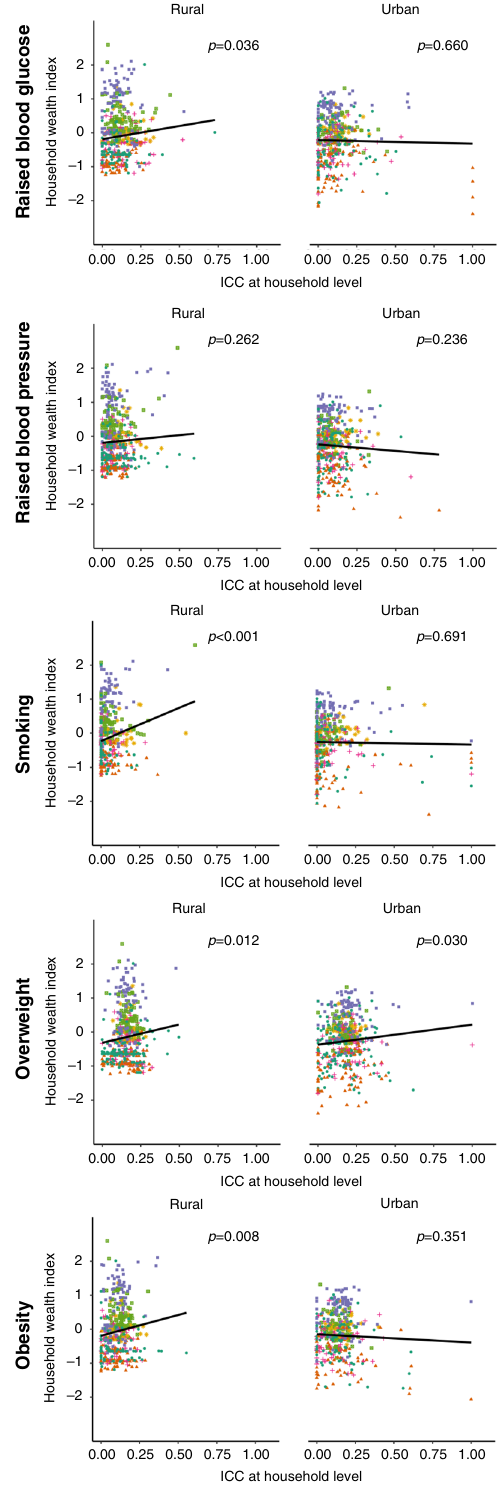
Using population-based data on over one million adults across India, this study identi fi ed a wide degree of variation of the level of clustering of CVD risk factors between risk factors and type of socio-geographic level (households, communities, districts, or